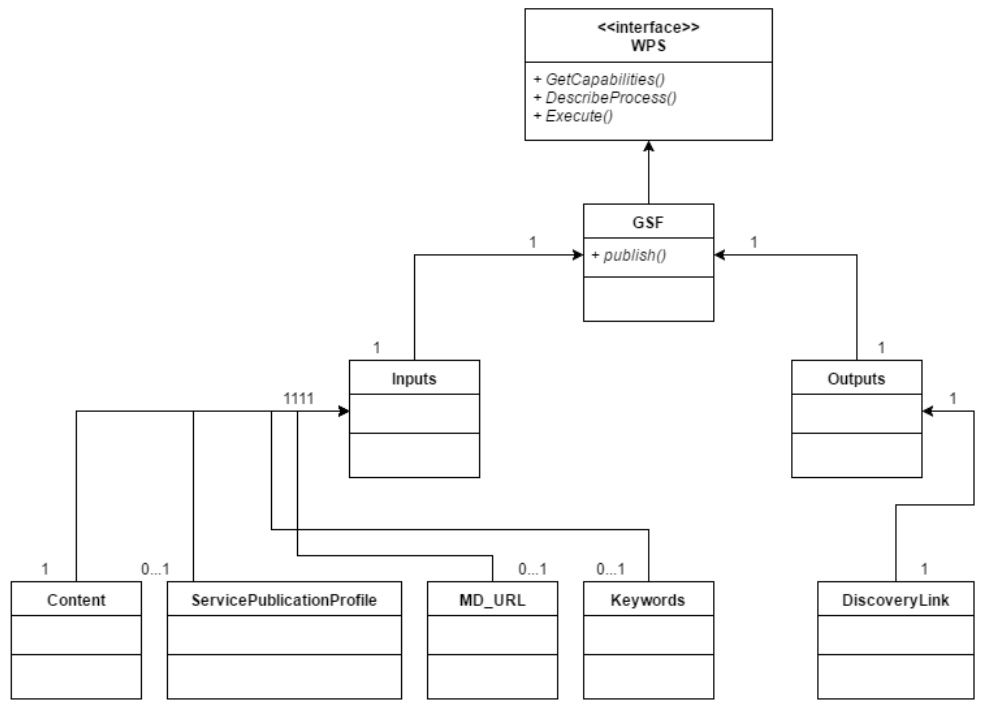
Figure 4. UML with input and output parameters of the GFS. WPS: Web Processing Service; URL: Uniform Resource